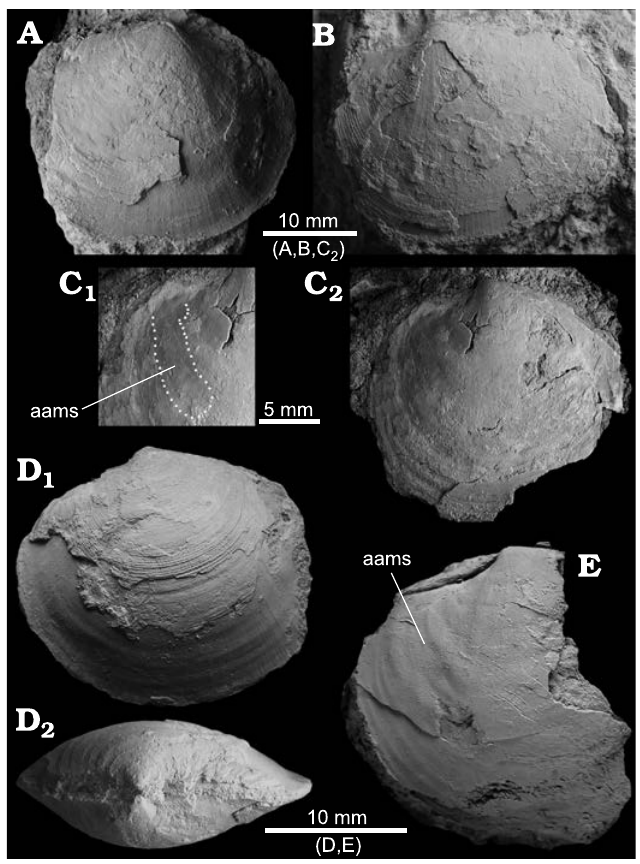
Fig. 11. The lucinid bivalve Elliptiolucina sp. from Upper Miocene